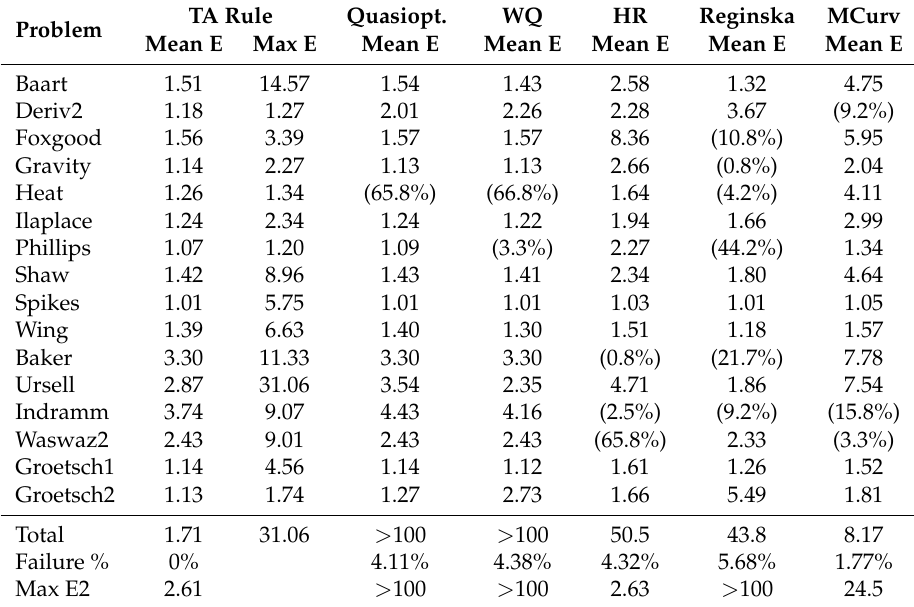
Table 4. Averages of error ratios E and failure % (in parenthesis) for heuristic rules.